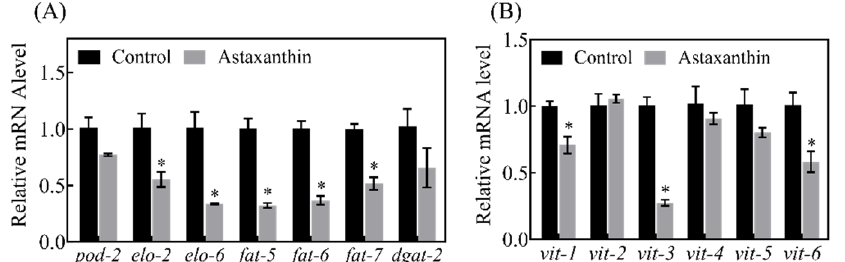
Figure 7. Effects of astaxanthin on the expression of genes related to lipid metabolism. Worms were treated with or without astaxanthin for 6 days. The mRNA levels of genes related to fatty acid syn ‐ thesis ( A ) and vitellogenin ( B ) were determined by qRT ‐ PCR. The expression of pmp ‐ 3 was used as the internal control. Data were expressed as mean ± SE, n = 3. * Significantly different from the un ‐ treated worms ( p < 0.05).